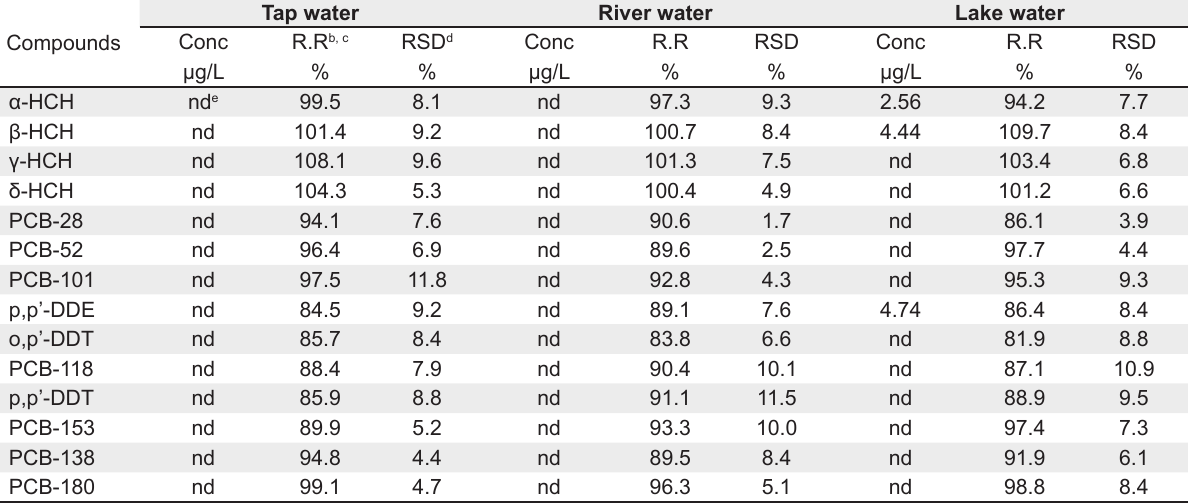
Table 5. Relative recoveries and relative standard deviations of OCPs and PCBs from real water samples